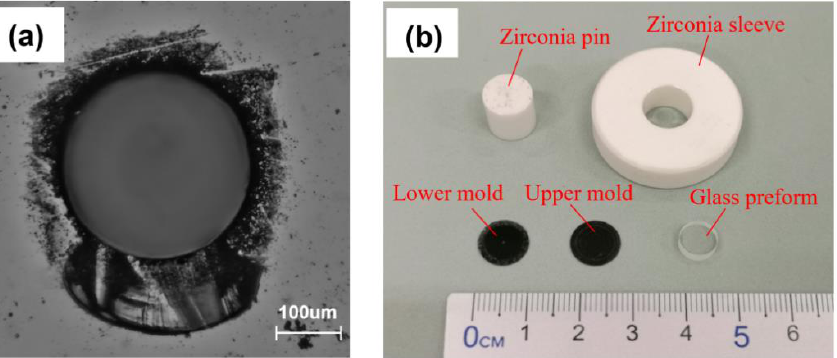
Figure 3. ( a ) Optical microscopy of the microhole at the central of the SiC lower mold. ( b ) Glass, mold and the mold